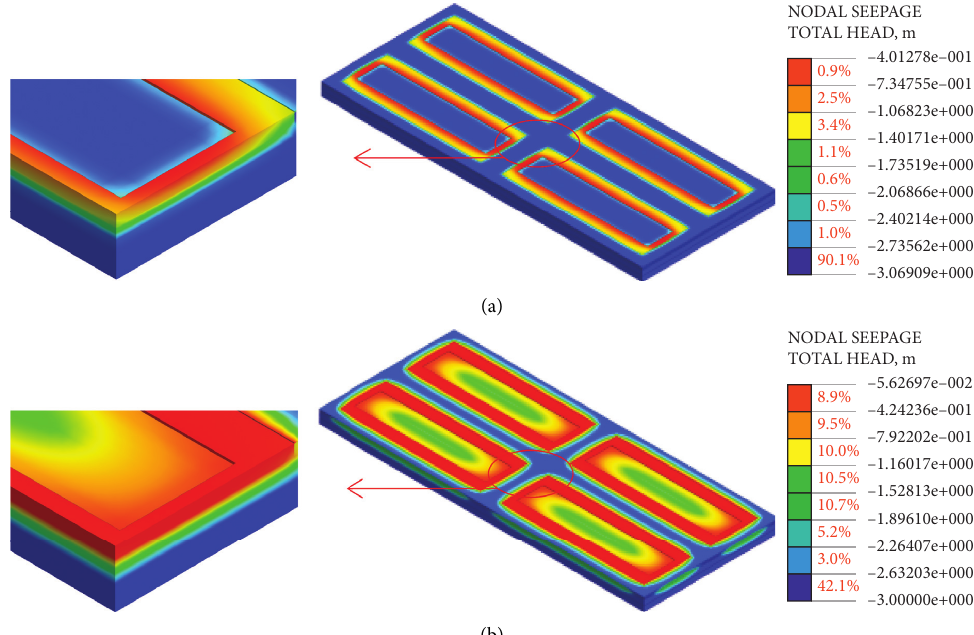
Figure 17: Total head nephograms of buildings without seepage wells after (a) 10min and (b) 120min of rainfall in the numerical model (the color of the legend represents the total head range. The value of the legend represents the total head value. The red % represents the volume percentage of color legend in the whole numerical model.).